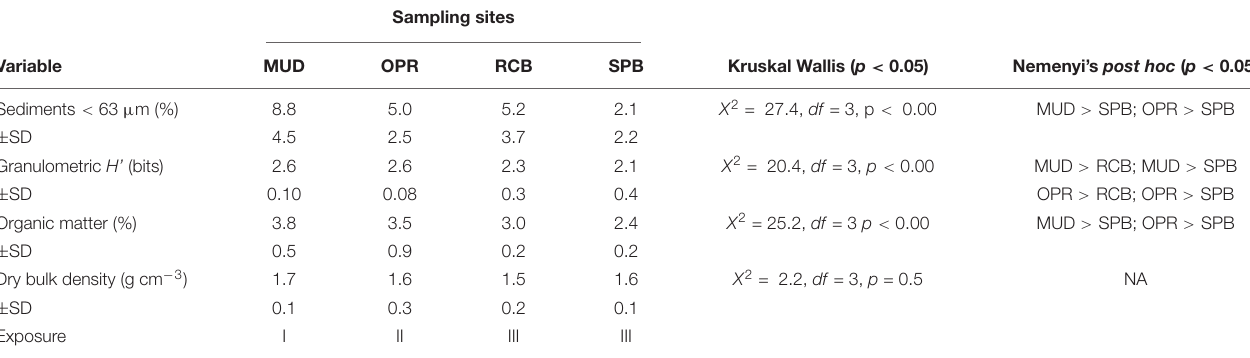
TABLE 2 | Mean of sediment variables in sampling sites (MUD, OPR, RCB, and SPB). Mud-like sediments ( < 63 µ m) and Granulometric H’ values are means of 18 replicates. Sampling sites